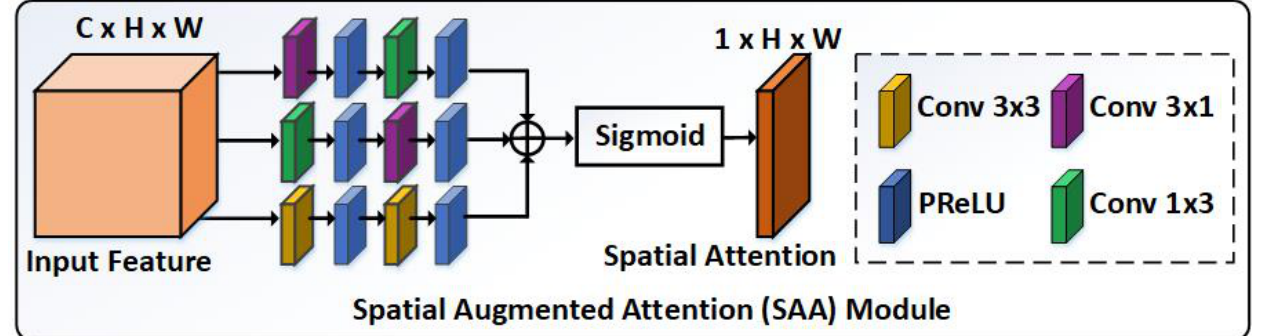
Figure 2. The overview of spatial augmented attention module. ⊕ denotes the element-wise